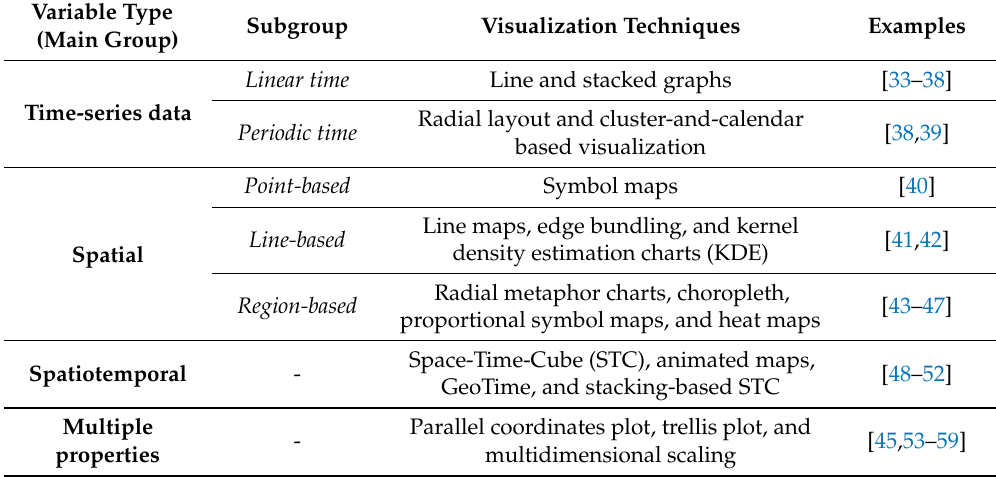
Table 1. Categorizing visualization techniques for transportation data, adapted from Chen et al.